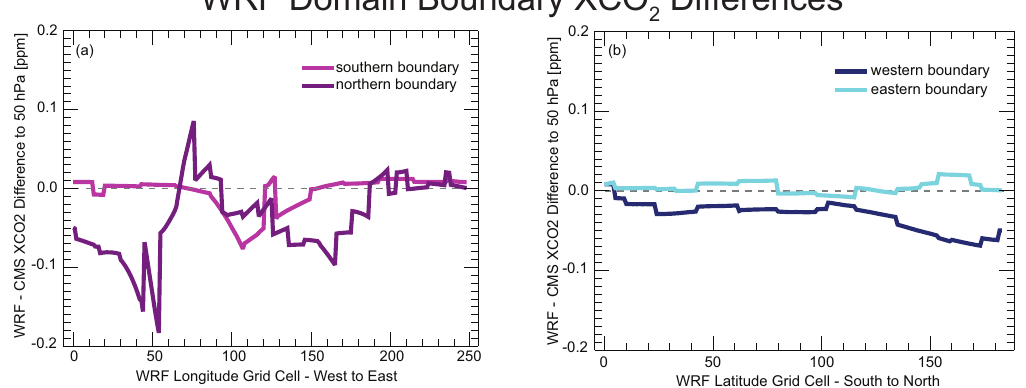
Figure 2. Differences in column-averaged CO 2 (to 50 hPa) of WRF boundary grid cells compared to the source Carbon Monitoring System (CMS)-Flux GEOS-Chem grid cells (up to 48 hPa). The southern and northern boundaries ( a ) are mostly over land, illustrating the effects of grid surface and surface pressure differences. The western and eastern boundaries ( b ) are over ocean, except for the northern end of the western